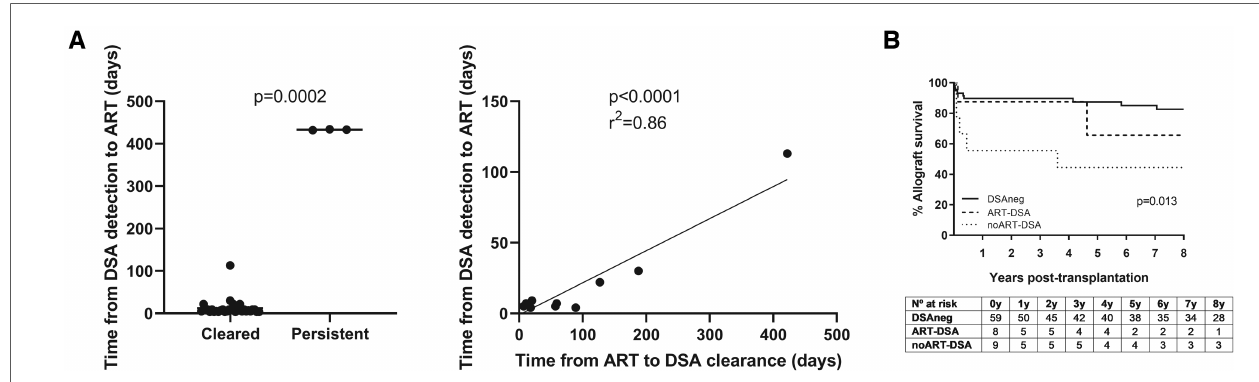
FIGURE 3 ( A ) Analysis of the elapsed time between DSA detection and antibody-removal procedure: comparison in cleared and persistent DSA and correlation with the time until DSA clearance. ( B ) Eight-year graft survival analysis in DSAneg, ART-DSA, and noART-DSA recipients.